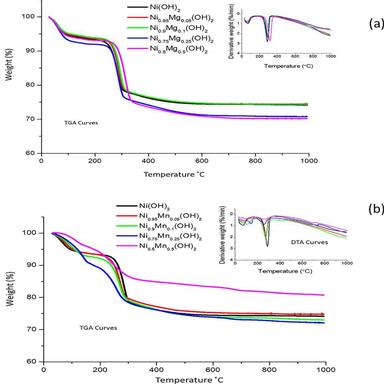
TGA-DTA curves of (a) Ni1-xMgx(OH)2 compared to the un-doped Ni(OH)2, (b) Ni1-xMnx(OH)2 compared to the un-doped Ni(OH)2.